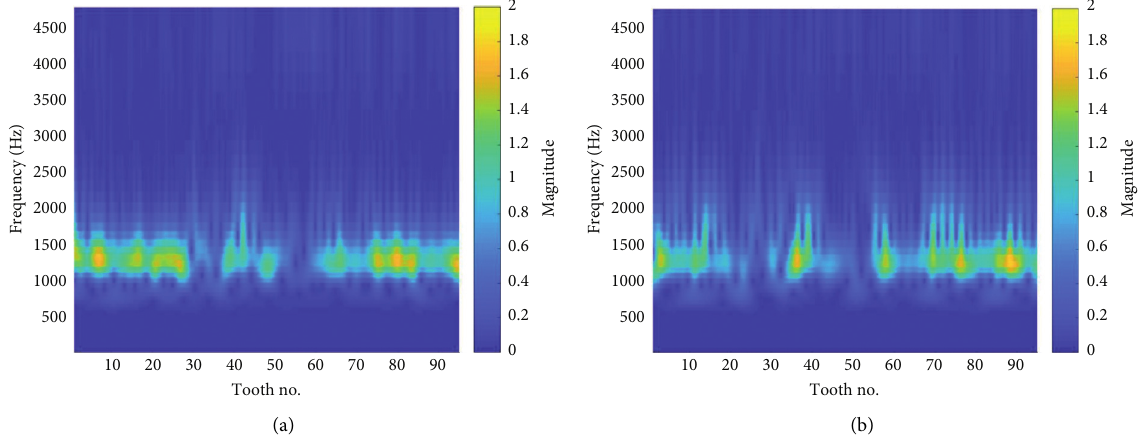
Figure 8: Wavelet analysis: (a) 300 hours and (b) 400 hours of experiment.